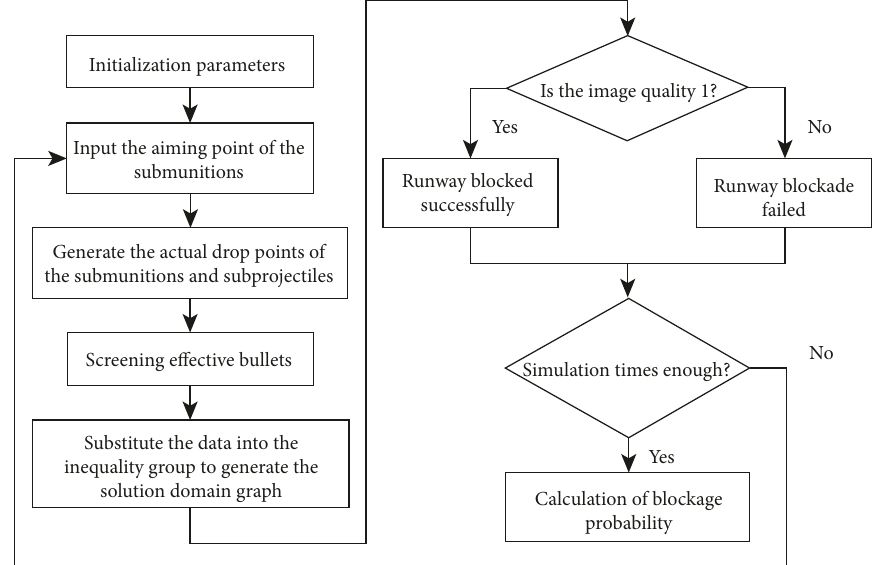
Figure 10: Simulation flowchart.